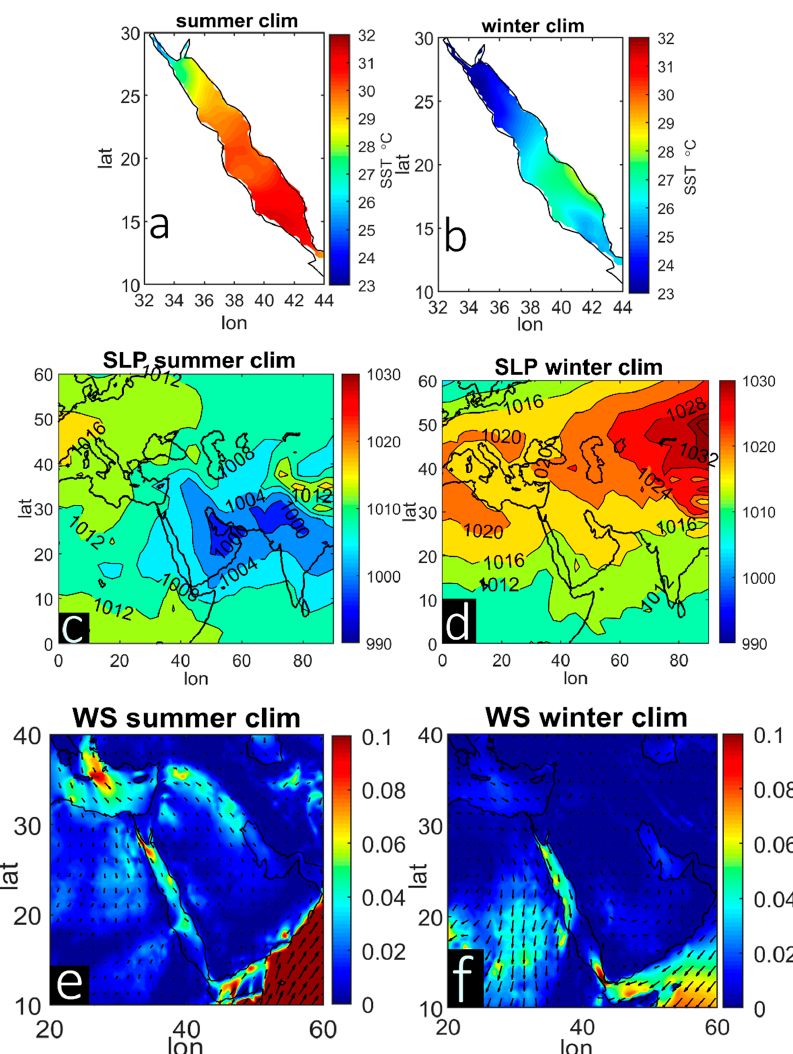
Figure 2. Summer and winter climatology of the sea surface temperature (SST) in ◦ C ( a , b ), sea level pressure (SLP) in hPa ( c , d ), and wind stress magnitude in Pa (shaded color) and wind stress direction (black arrows) ( e , f